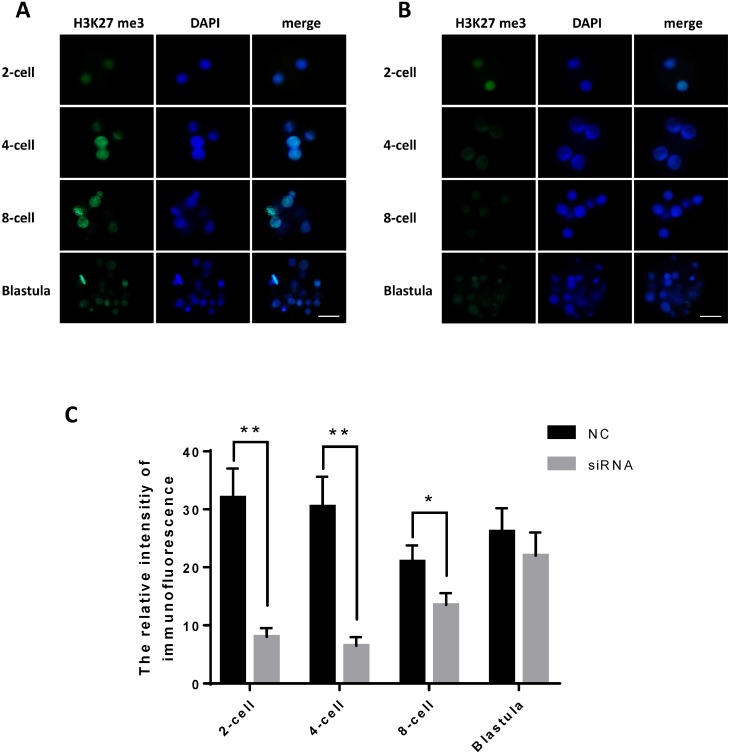
JARID2 knockdown affects histone H3K27 methylation at the 2-cell, 4-cell, 8-cell and blastula stages.(A) H3K27me3 immunofluorescence staining in the negative control group; green FITC fluorescence represents H3K27me3 expression, and blue DAPI fluorescence represents the location of DNA in the cell nucleus. Scale bar = 100 µm. (B) H3K27me3 immunofluorescence staining in the JARID2 knockdown group. Scale bar = 100 µm. (C) Immunofluorescence intensity analysis. H3K27 methylation of the knockdown group at the 2-cell, 4-cell stages are extremely significantly lower than that of the negative control group at the same stages (p < 0.01), and at 8-cell stages are significantly lower (p < 0.05) than control group; however, at the blastula stage, H3K27 methylation is not significantly different between the two groups (p > 0.05). Data are presented as the mean ± SD derived from triplicate transfectants of three independent experiments. ∗ denotes a statistically significant difference (p < 0.05), and ∗∗ denotes an extremely significant difference (p < 0.01).